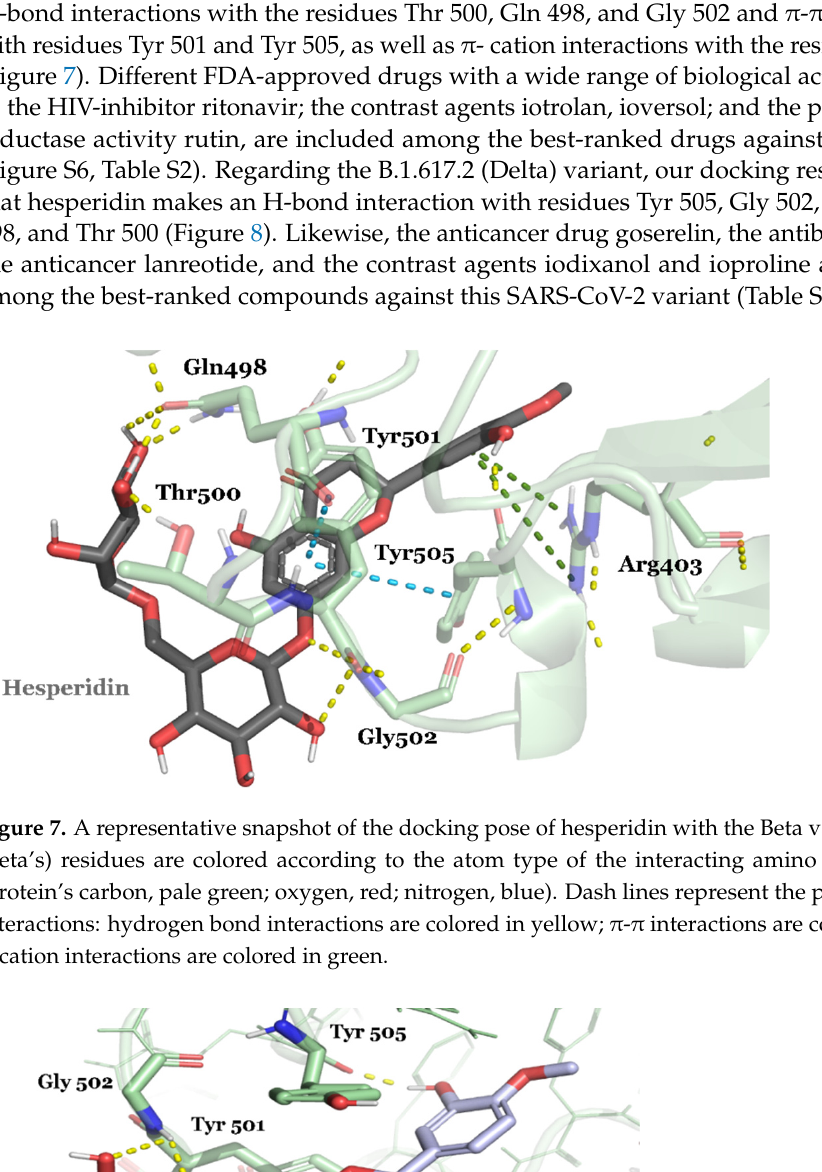
Figure 6. A representative snapshot of the docking pose of hesperidin with the Alpha variant. B.1.1.7 (Alpha’s) residues are colored according to the atom type of the interacting amino acid residues (protein’s carbon, pale green; oxygen, red; nitrogen, blue). Dash lines represent the protein–ligand interactions: hydrogen bond interactions are colored in yellow; π - π interactions are colored in blue.